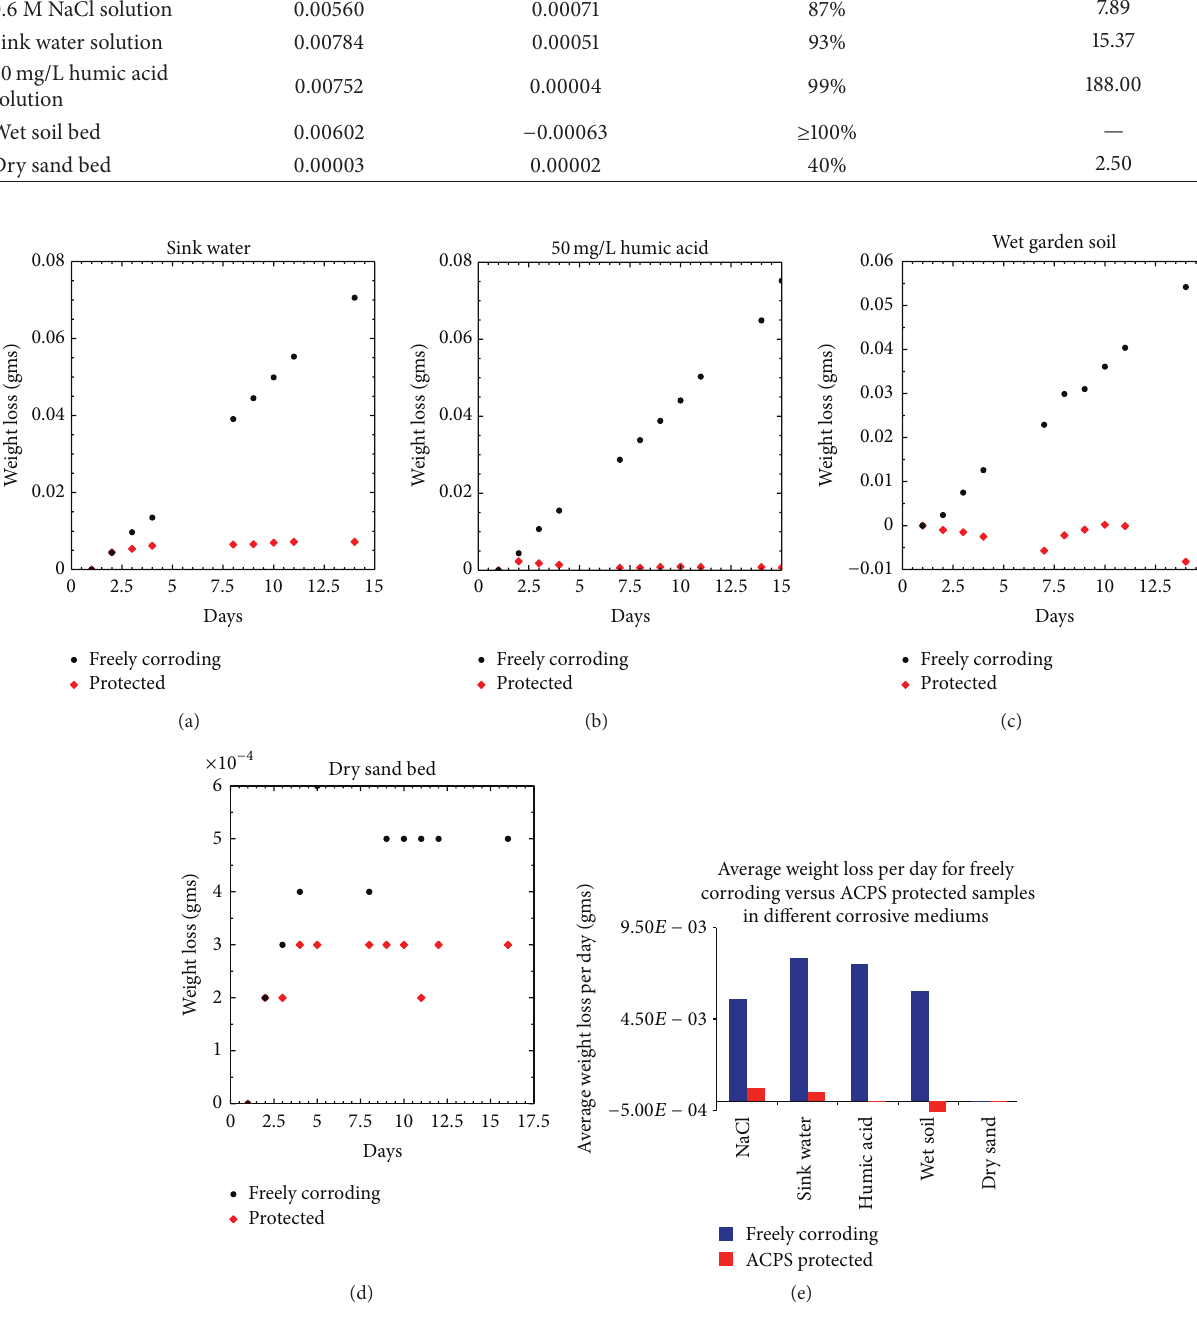
Figure 8: The weight loss of the freely corroding and the protected metal samples for more than two weeks in (a) the sink water solution, (b) the 50 mg/L humic acid solution, (c) the wet soil bed, and (d) the dry sand bed. Two A36 steel samples, one freely corroding and the other protected, are tested in each corrosive medium. (a) The weight loss of the freely corroding and the protected samples in the sink water solution for 13 days. (b) The weight loss of the freely corroding and the protected samples in the 50mg/L humic acid solution for 14 days. (c) The weight loss of the freely corroding and the protected samples in the wet soil bed for 14 days. (d) The weight loss of the freely corroding and the protected samples in the dry sand bed for 12 days. (e) The calculated average weight loss per day for the freely corroding and the protected samples in all corrosive